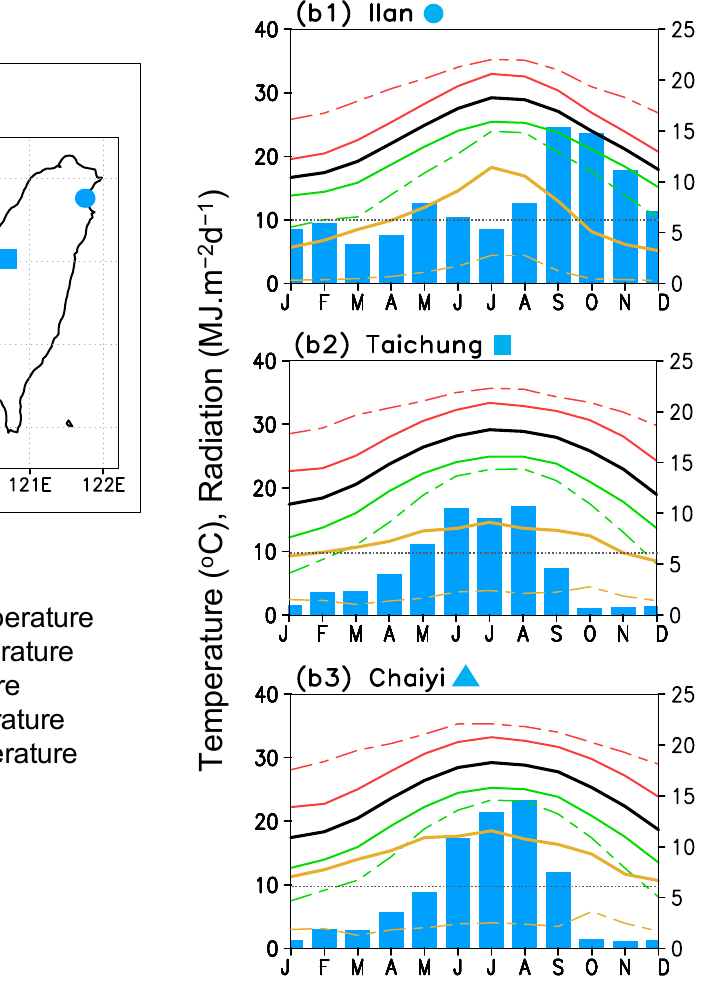
Figure 1. Panel ( a ) shows location of Taiwan (red box) and study areas; Ilan (circle), Taichung (square), and Chaiyi (triangular), and panels ( b1 – b3 ) present climatology patterns of Ilan (1987–2016), Taichung (1990–2016), and Chaiyi (1987–2016).